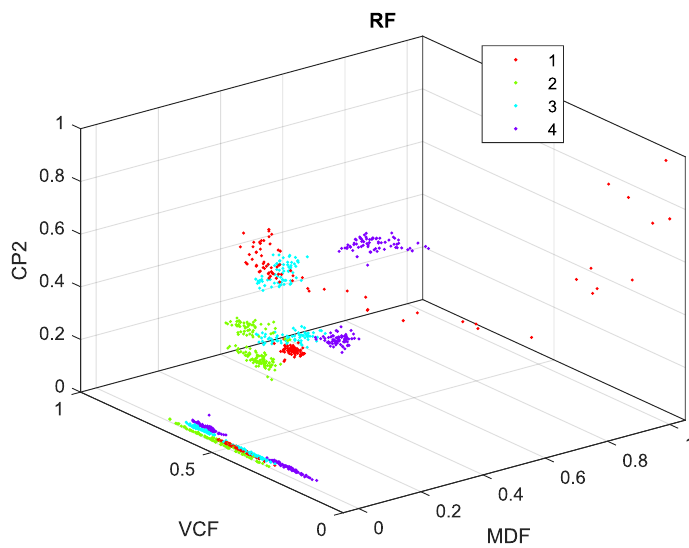
Figure 7. Scatter plot using 3 best CIs of CI_DFRL.